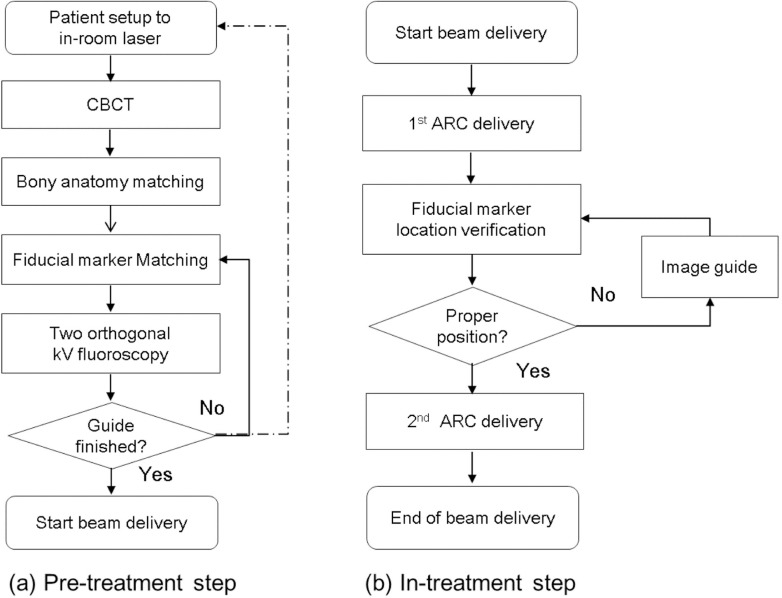
Protocol for marker-guided gated volumetric-modulated arc therapy.The protocol consists of two steps—pre-treatment and in-treatment. (a) Pre-treatment: patient alignment and image guidance are performed. If alignment is significantly out of range at each procedure, patient alignment is performed again. (b) In-treatment: after delivering the first arc dose, the half-time fiducial markers are verified.